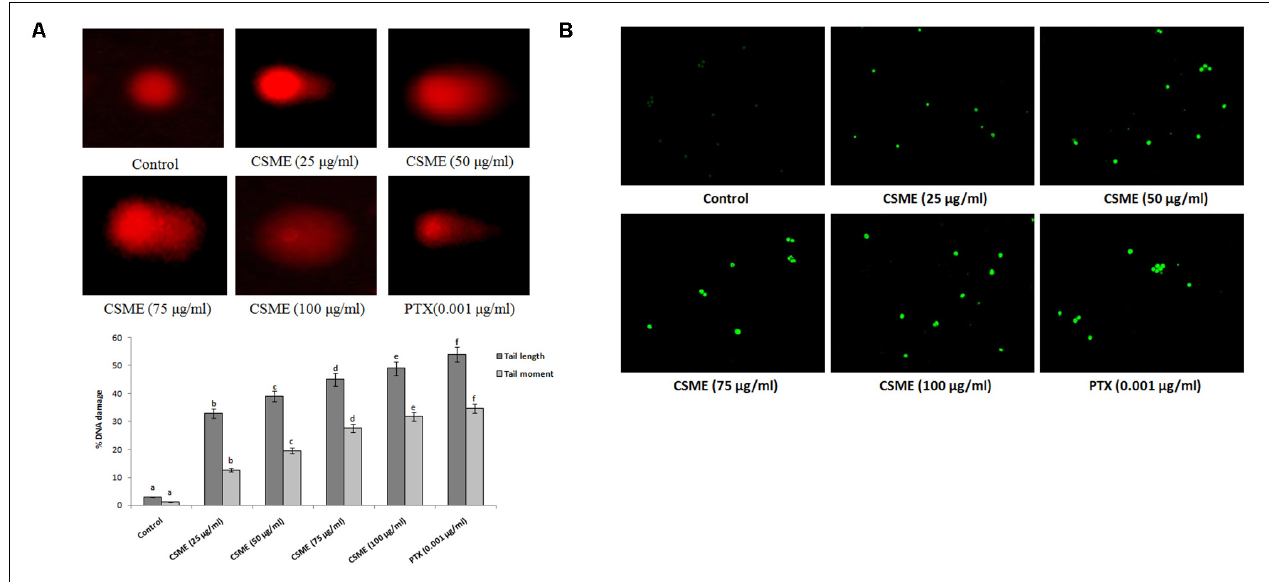
FIGURE 3 | (A) CSME induces DNA damage in MDA-MB-231 cells. MDA-MB-231 cells were treated with different concentrations of CSME for 24 h. Cells lysates were electrophoresed and DNA strand breaks were detected by ethidium bromide staining using single-cell gel electrophoresis. The fluorescence micrographs show tail DNA and tail moment in CSME-treated MDA-MB-231cells. (B) TUNEL assay was carried out to detect CSME-induced DNA fragmentation in MDA-MB-231 cells. The images were taken under a fluorescence microscope (Floid cell imaging station, Invitrogen). Values are given as mean ± SD of six experiments in each group. Values not sharing a common marking (a, b, c, d, e, and f) differ significantly at P < 0.05 versus control (DMRT).